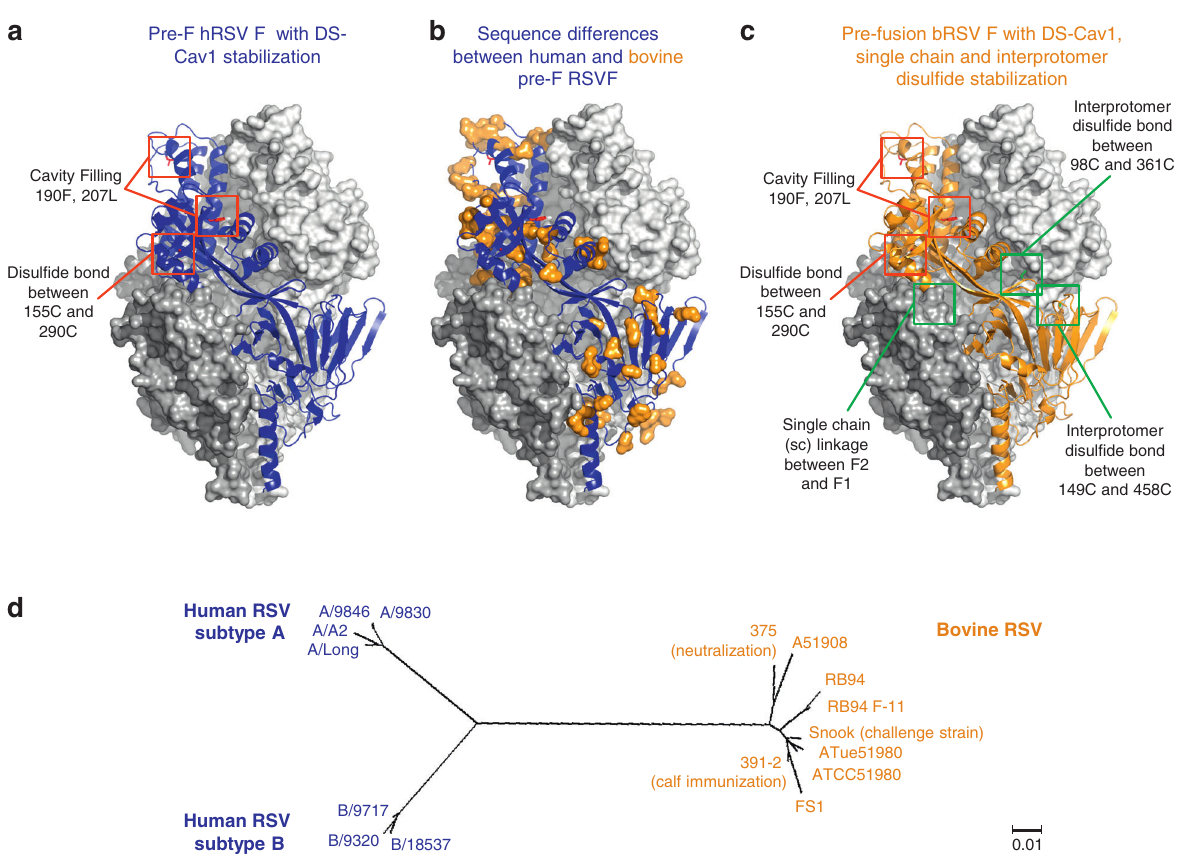
Fig. 1 Translation of pre-F hRSV F stabilization to bRSV F. a Structural model of a pre-F hRSV F trimer stabilized by DS-Cav1 mutations (PDB ID 4MMU). 17 One monomer is depicted by a blue ribbon model with the four DS-Cav1 mutations shown by red stick models outlined by red squares . The other two monomers are depicted by gray surface representations. b Sequence variation between hRSV strain A2 and eight different bRSV strains is mapped ( orange surface representation) onto a blue ribbon model of one monomer of a DS-Cav1 pre-F RSV F trimer colored as in a . c The locations of the DS-Cav1 mutations ( red ), the sc linkage ( green ) and interprotomer disul fi de stabilization mutations ( green ) introduced into bovine RSV F protein are indicated by boxed stick models for one RSV F monomer. In b and c , the other two monomers of the trimer are shown as gray surface representations. d Phylogenetic tree for human ( blue ) and bovine ( orange ) RSV F proteins. Names shown indicate the virus strain or isolate with study usage shown in parentheses. GenBank accession numbers for all strains used in this study are shown in Supplementary Table